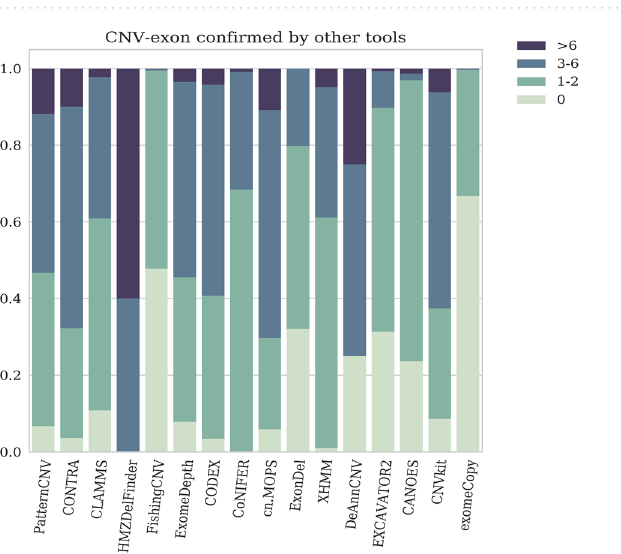
Figure 3. Distribution of predicted CNVs over length ( a ) and number of targeted regions ( b ).